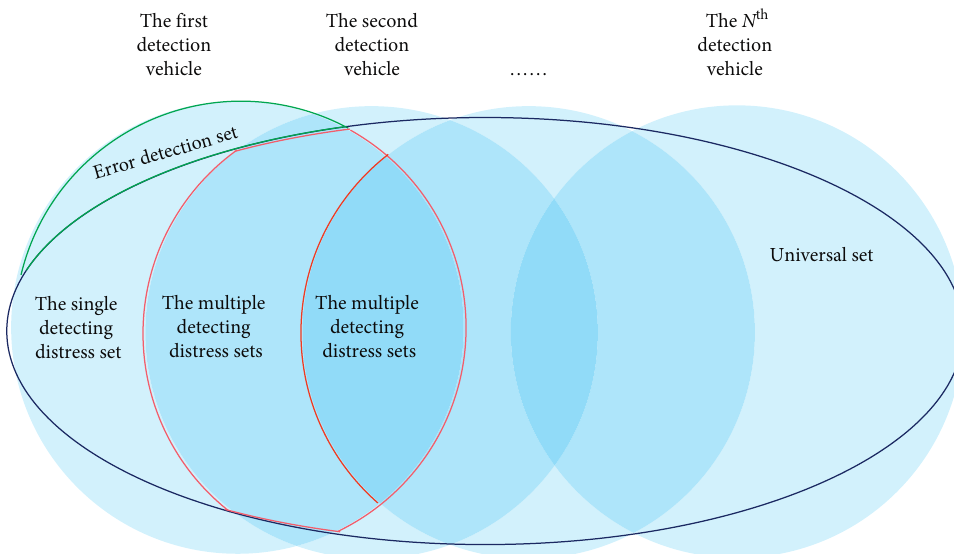
Figure 14: The fusion result of multiple